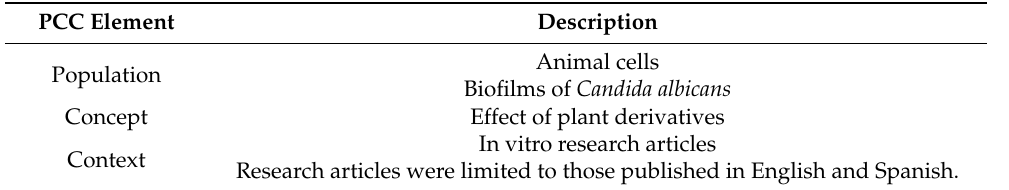
Table 5. Focused research questions presented using the PCC policy format.